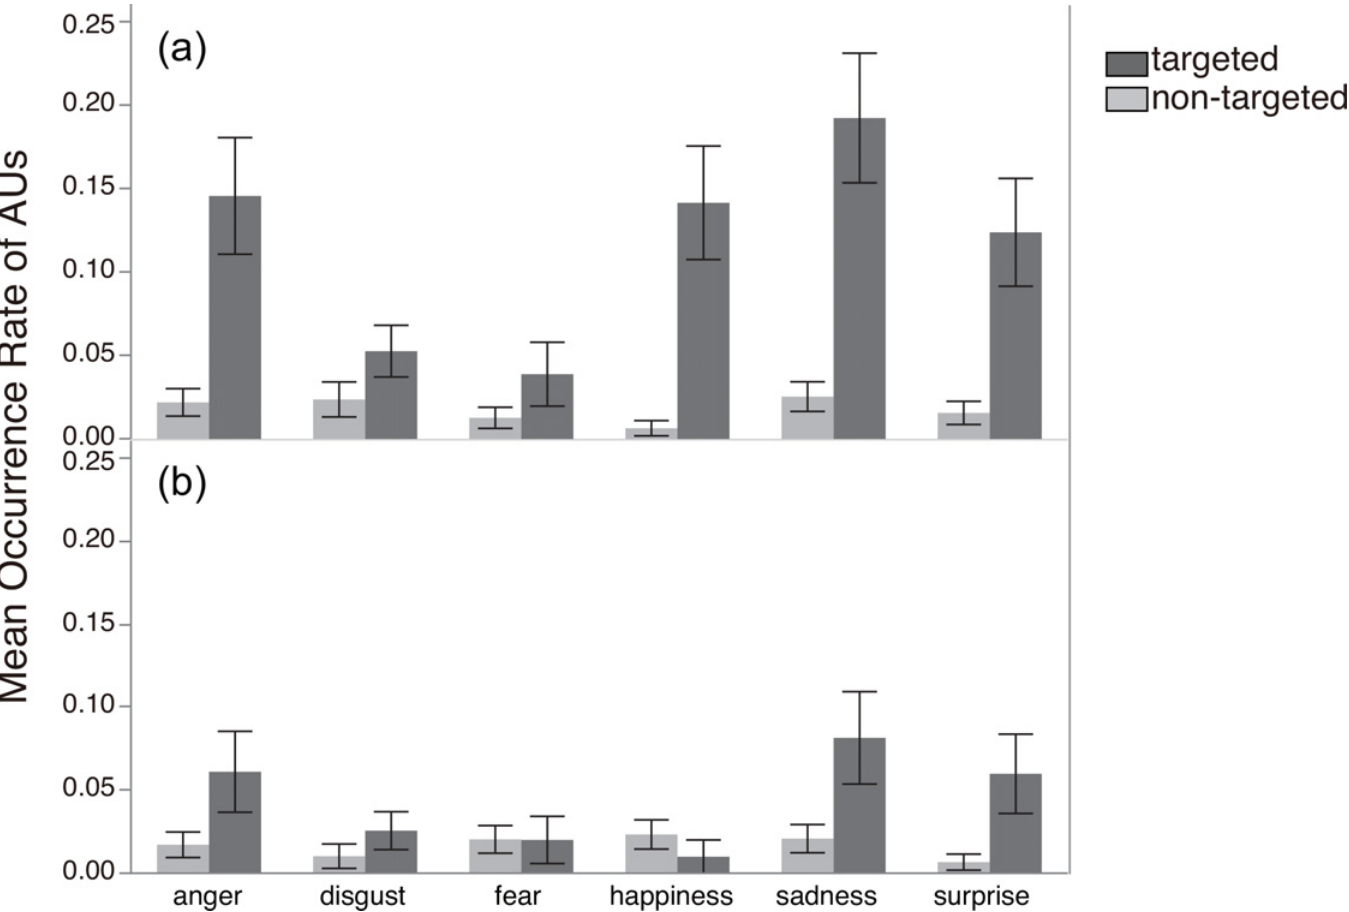
Fig 5. Mean occurrence rates of each AU type (targeted and non-targeted) when participants were (a) inferring emotional states (N = 28) or (b) judging external traits (N = 27) of the targets. Error bars represent standard error of the